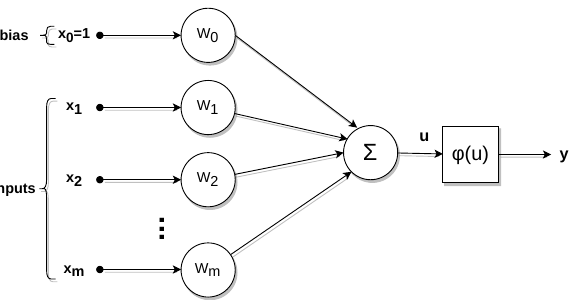
Figure 7. Artificial neuron